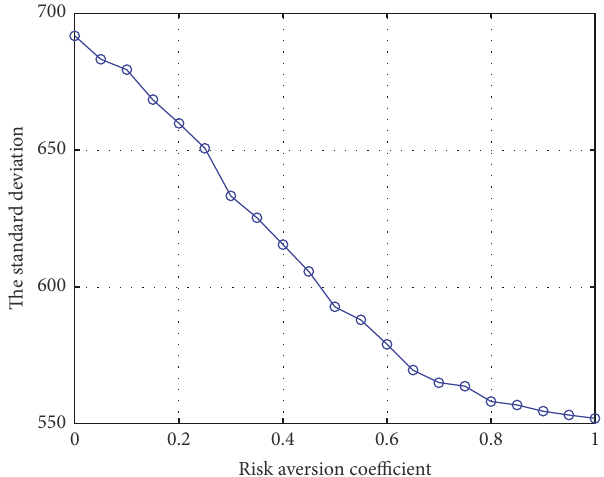
Figure 7: The standard variation for different risk-aversion coeffi- cient 𝜆 .